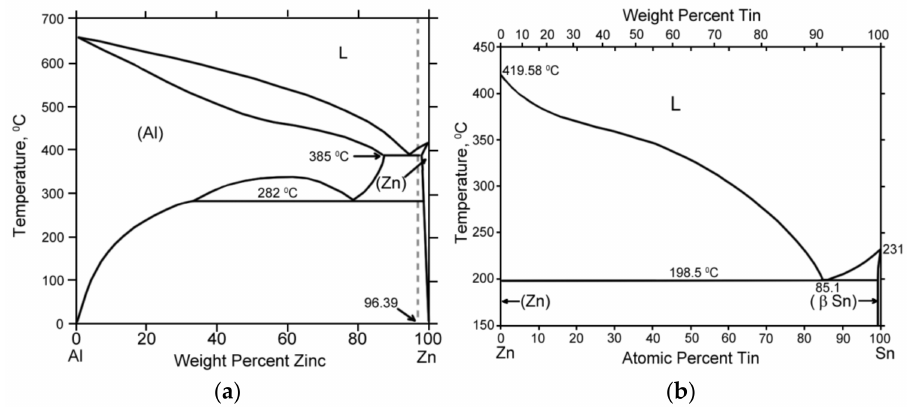
Figure 1. Phase diagrams of Al–Zn ( a ) and Zn–Sn ( b ) binary alloys.